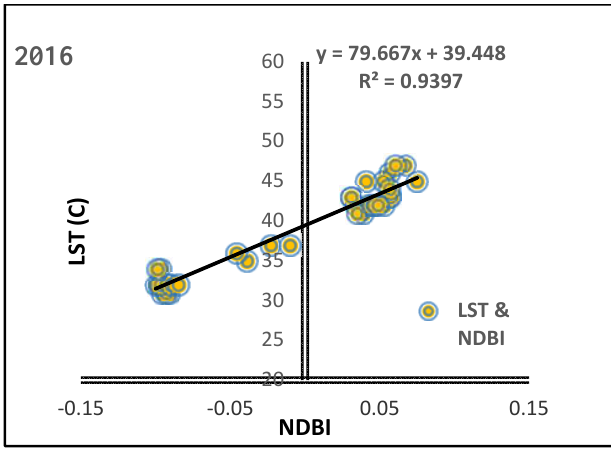
Figure 9. Correlation between NDBI and LST in the period of the study (1990, 2000 and 2016).